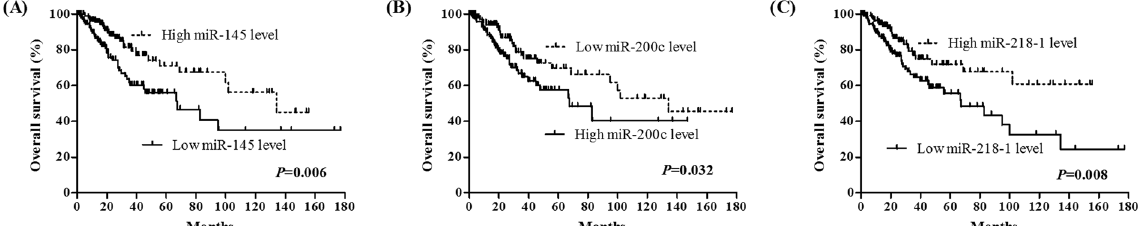
Figure 2. Three miRNAs were associated with overall survival in cervical cancer patients by using Kaplan- Meier curve and Log-rank test. The patients were stratified into high level group and low level group according to median of each miRNA. ( A ) miR-145; ( B ) miR-200c; and ( C ) miR-218-1.